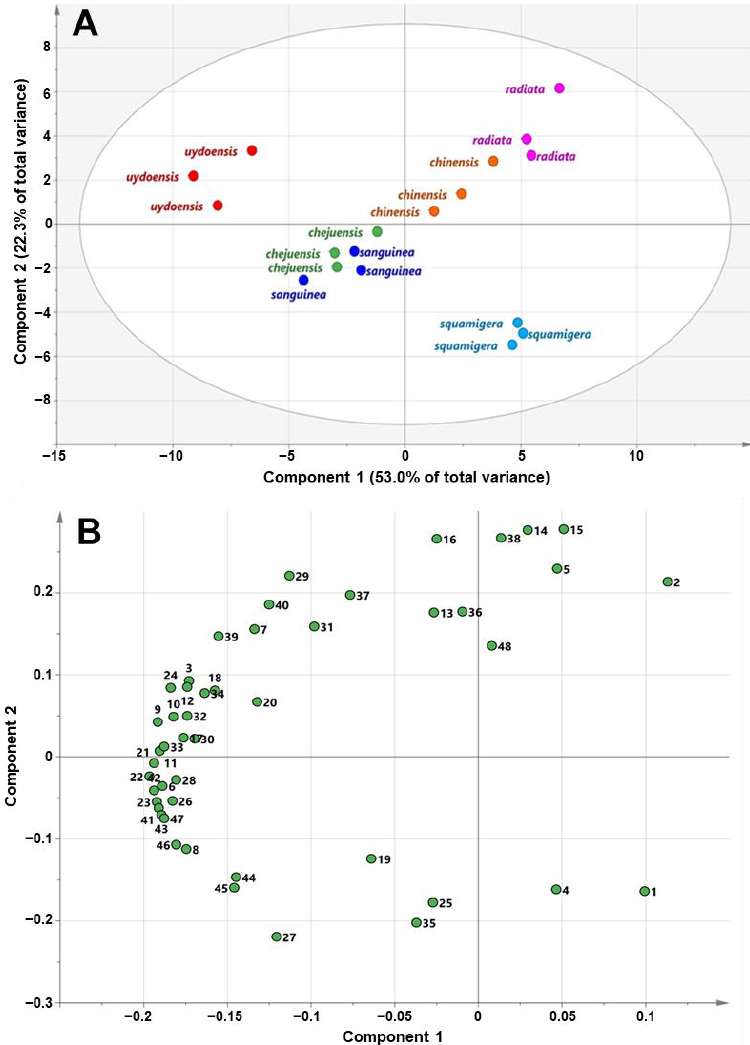
Figure 3. ( A ) Score plot; ( B ) loading plot of principal component analysis (PCA) derived from gas chromatography time- of-flight mass spectrometry (GC-TOFMS) metabolite profiles. 1. Pyruvic acid; 2. Lactic acid; 3. Alanine; 4. Oxalic acid; 5. Glycolic acid; 6. Valine; 7. Ethanolamine; 8. Phosphoric acid; 9. Glycerol; 10. Leucine; 11. Isoleucine; 12. Proline; 13. Glycine; 14. Succinic acid; 15. Glyceric acid; 16. Fumaric acid; 17. Serine; 18. Threonine; 19. β -Alanine; 20. Malic acid; 21. Aspartic acid; 22. Methionine; 23. Pyroglutamic acid; 24. 4-Aminobutyric acid; 25. Threonic acid; 26.